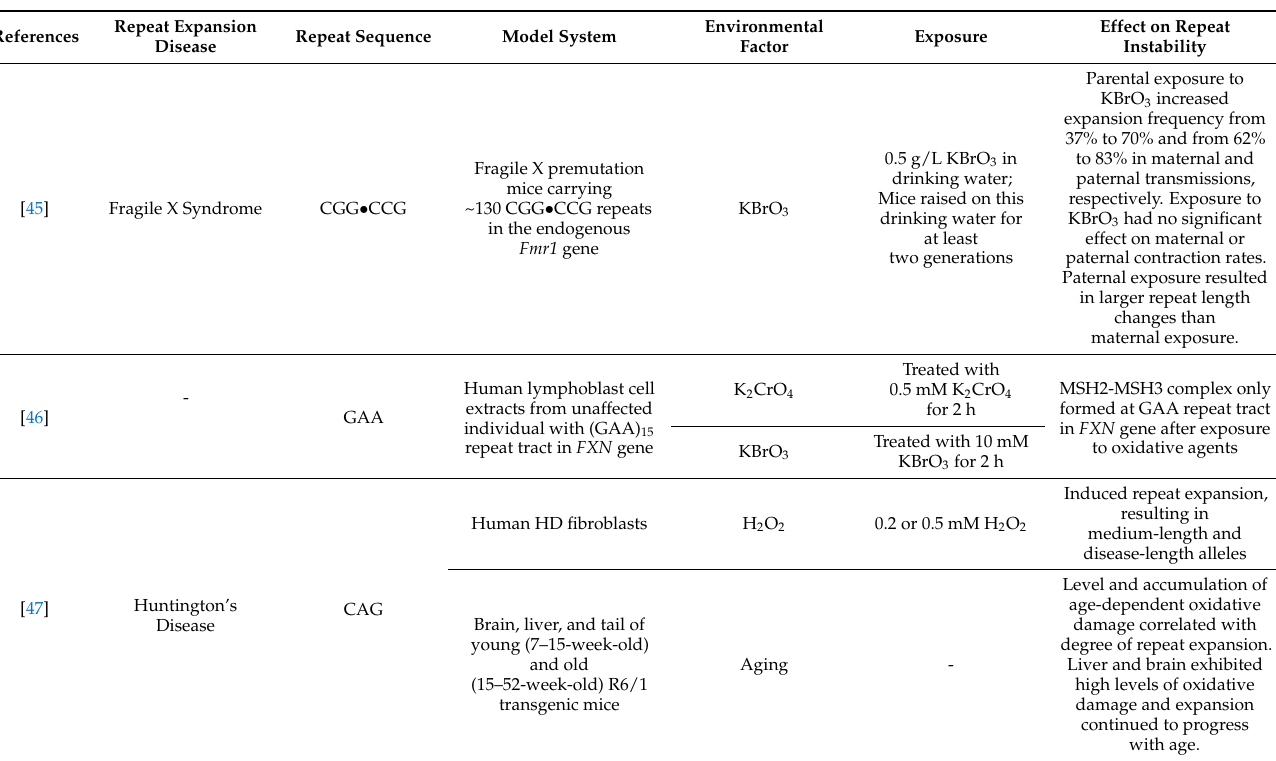
Table 1. Effects of Environmental Factors on Repeat Instability. Several environmental factors have been found to modulate repeat instability across a variety of repeat expansion diseases and model